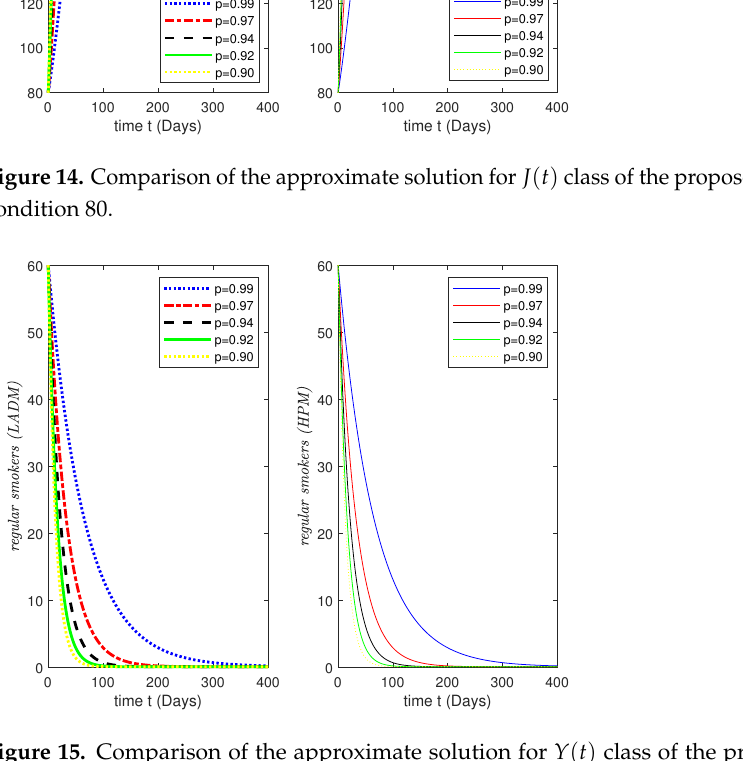
Figure 15. Comparison of the approximate solution for Y ( t ) class of the proposed model having initial condition